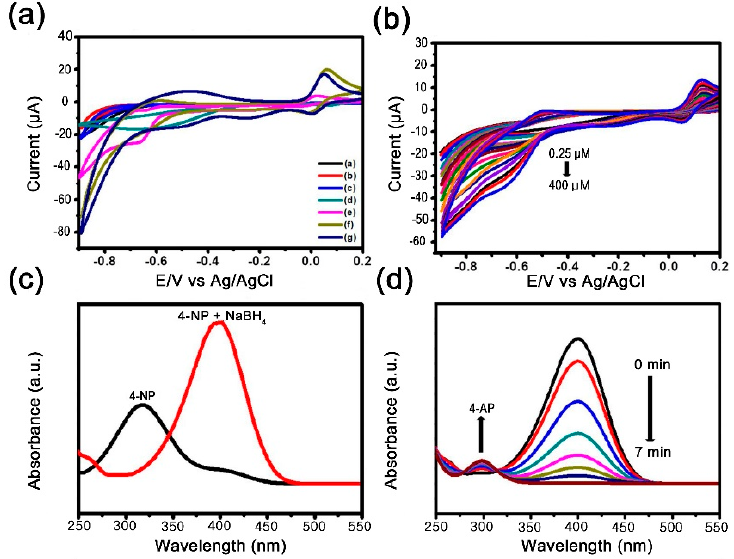
Figure 6. ( a ) CVs of the identical electrodes in 0.1 M PBS solution including 0.5 mM of